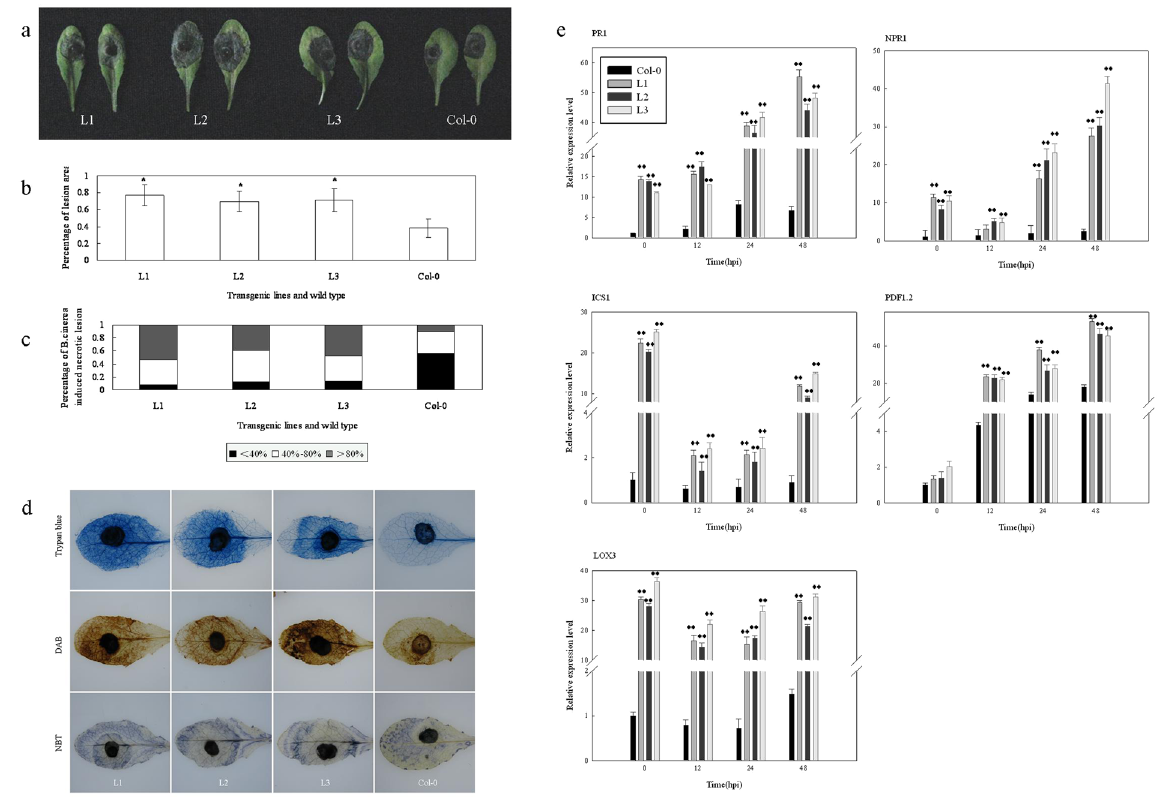
Figure 5. Response of VqTLP29 over-expressing Arabidopsis thaliana lines to B . cinerea inoculation. ( a ) Disease symptoms in representative rosettes of the 4-week old VqTLP29 transgenic line L1, L2, L3 and Col-0 after B . cinerea inoculation for 3 days. Leaves were detached and inoculated by dropping 10 μ l spore suspension with the concentration of 2.0 × 10 6 spores ml − 1 onto the adaxial surface. Leaves were highly moisturizing until the lesion shown. ( b ) Percentage of the leaves covered by the lesions 3 days post B . cinerea inoculation. Lesion sizes of the VqTLP29 transgenic lines and Col-0 were measured in three independent experiments using grid statistics. Data represent mean values ± SD with 50 leaves per sample. Asterisks indicate statistical significance ( * 0.01 < P < 0.05, one-way ANOVA). ( c ) Symptoms of the VqTLP29 transgenic lines and Col-0 3 days post B . cinerea inoculation were scored by defining three lesion classes ( < 40%, 40–80%, > 80%). The black part represents percentage of B . cinerea induced necrotic lesion sizes less than 40%, the white part represents percentage of lesion sizes between 40% to 80%, and the gray part represents percentage of lesion sizes more than 80%. The sum of the percentages in three parts is 100%. ( d ) Cell death, H 2 O 2 and O 2 − accumulation in the VqTLP29 transgenic lines and Col-0 72 h post B . cinerea inoculation. Three infected leaves of the transgenic lines and Col-0 were required for each stain in three independent experiments. ( e ) Expression levels of disease resistance genes in the VqTLP29 transgenic lines and Col-0 at 0, 12, 24 and 48 hpi following B . cinerea inoculation. Asterisks indicate statistical significance ( * 0.01 < P < 0.05, ** P < 0.01, one-way ANOVA). The experiments were repeated three times with consistent